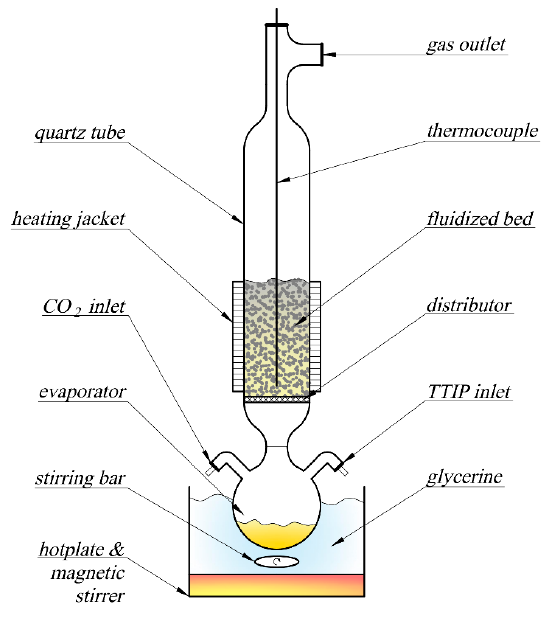
Figure 1. Fluidised-bed chemical vapour deposition (FB-CVD) experimental setup.